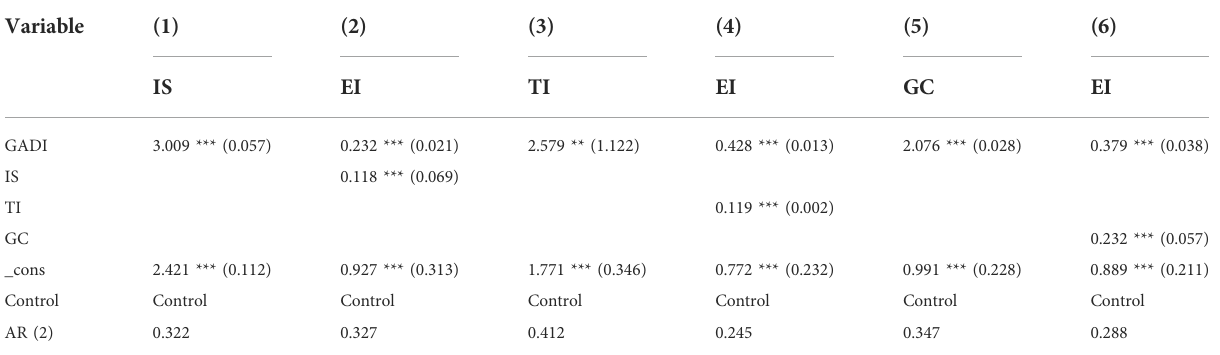
TABLE 9 Regression results of the intermediary